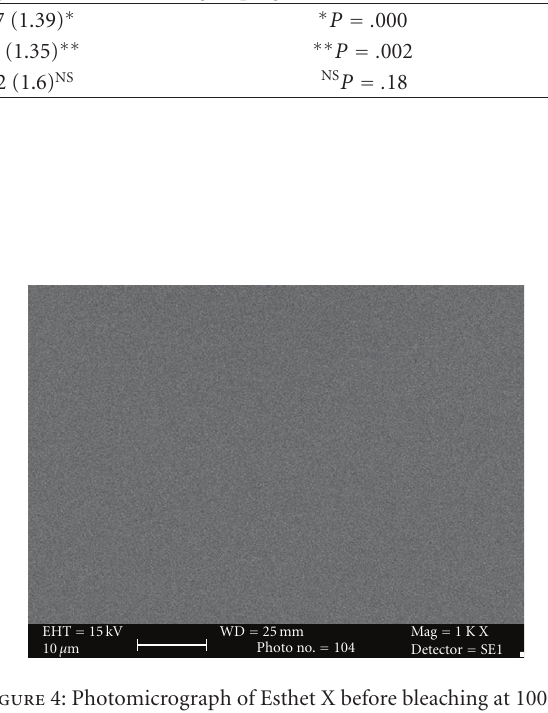
Figure 4: Photomicrograph of Esthet X before bleaching at 1000x.